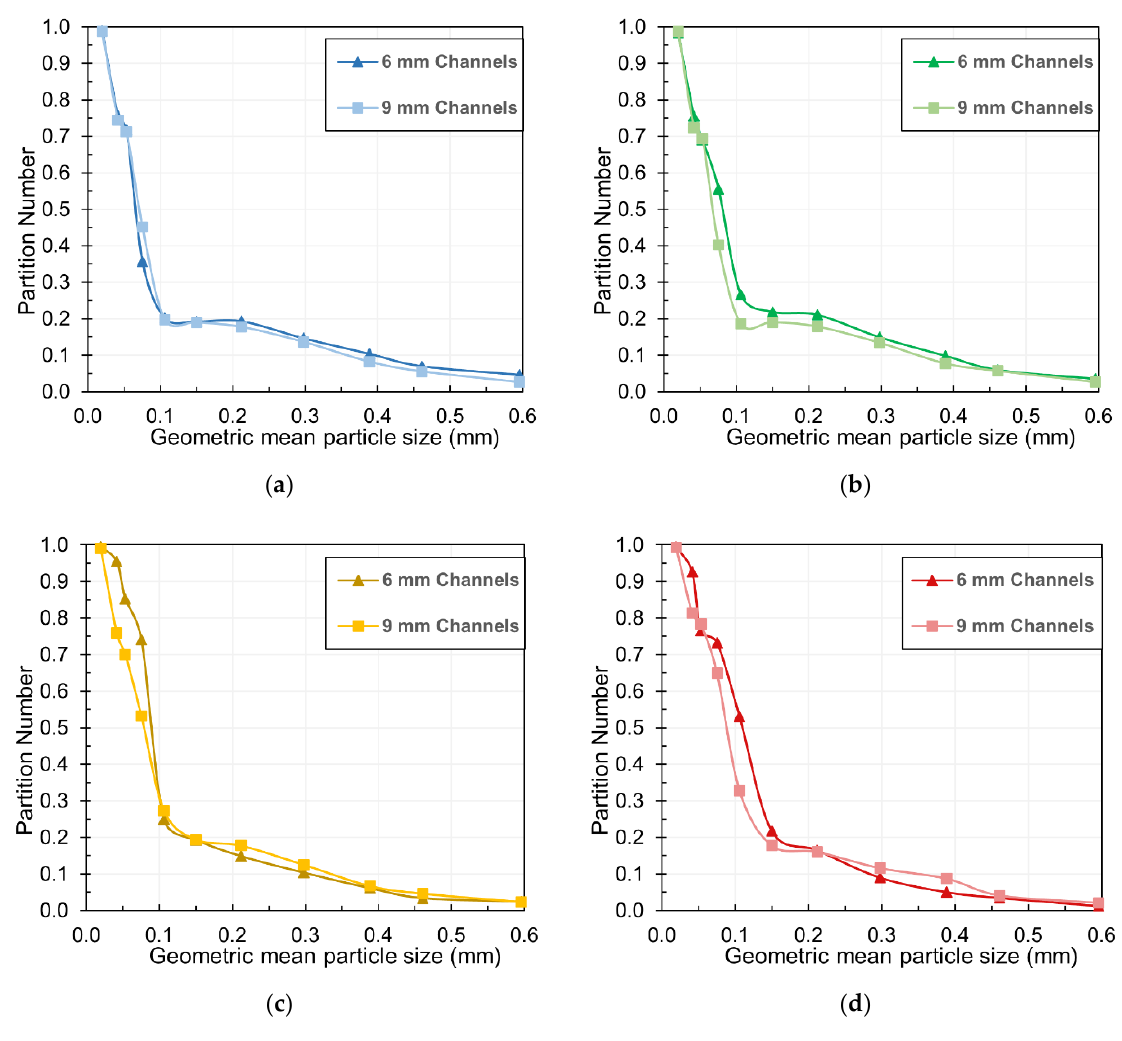
Figure 4. Partition-to-overflow product with 6 mm and 9 mm inclined channel spacings for four different sets of gas fluxes at ( a ) 0.075 cm/s, ( b ) 0.15 cm/s, ( c ) 0.3 cm/s, and ( d ) 0.45 cm/s.